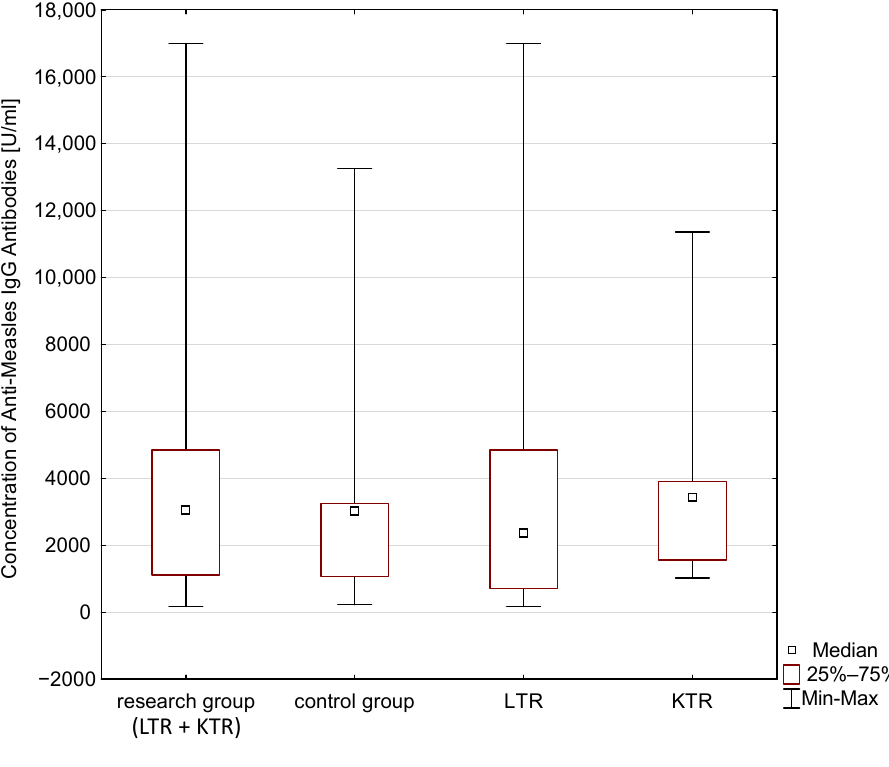
Figure 2. Concentration of Anti-Measles IgG antibodies in blood serum.